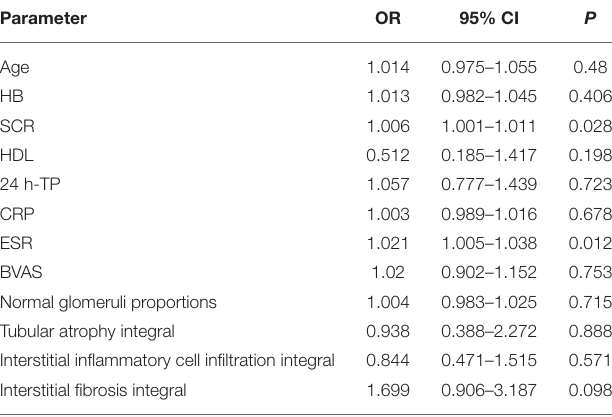
TABLE 5 | Results of the univariate analysis of RVLs. TABLE 6 | Logistic regression analysis of multiple factors in the occurrence